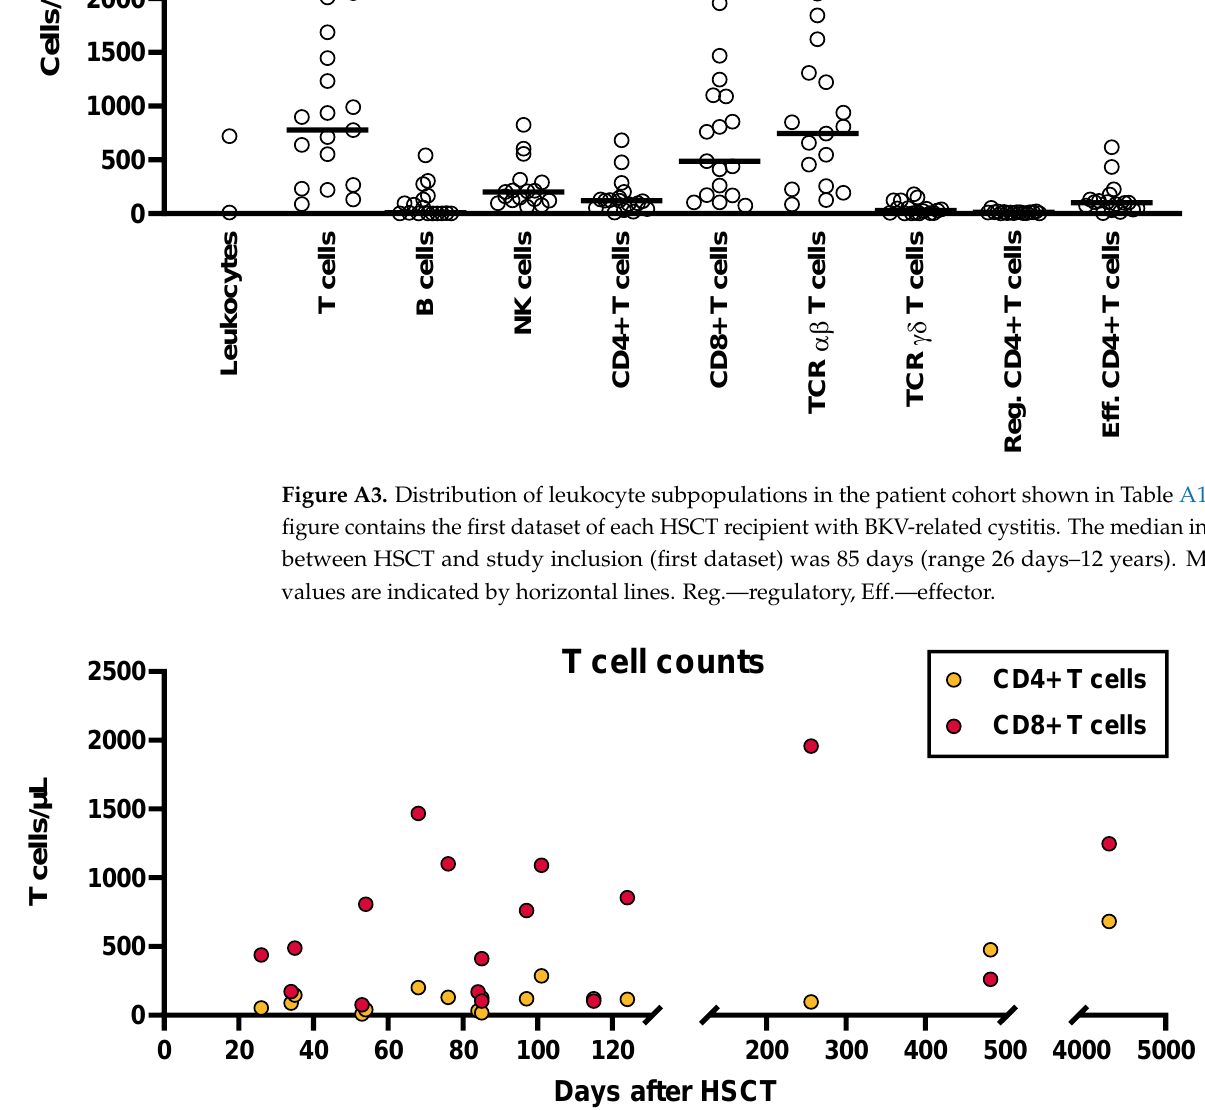
that CD4+ T-cell counts showed a stronger correlation with days after HSCT ( r = 0.46, p = 0.06) than CD8+ T-cell counts ( r = 0.28, p =